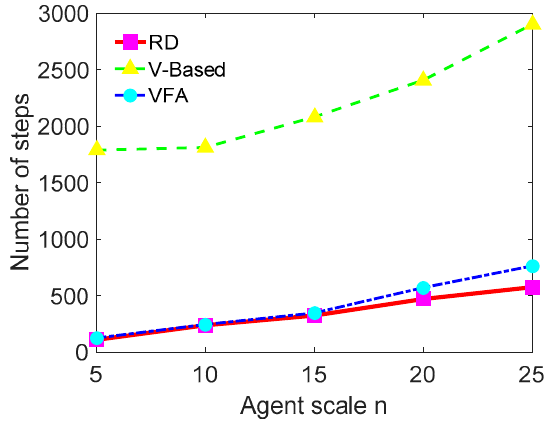
Figure 20. The comparison of convergence speed in different scale of UAVs. Table 3. Comparison of the calculation speed of UAVs’ scale ( n = 25).